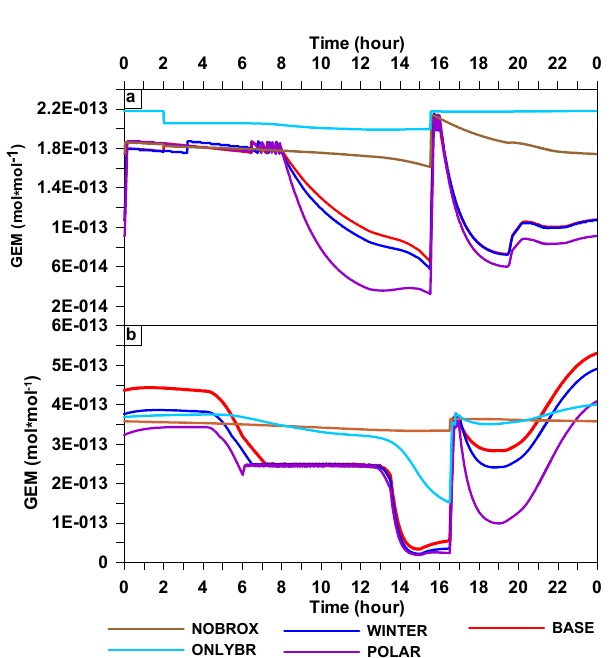
Fig. 7. Influence of BrO x and temperature on GEM depletion. The Figure 7. Influence of BrO X and temperature on GEM depletion. The influence of GEM diurnal profiles are shown for the “BASE”, “WINTER”, “PO- BrO X and temperature on GEM depletion rate. The GEM diurnal profiles are shown LAR”, “NOBROX”, and “ONLYBR” simulations for Julian days for the "BASE”, "WINTER”, "POLAR", "NOBROX," and "ONLYBR" simulations 188 (a) and 201 (b) for Julian days 188 (a) and 201(b).